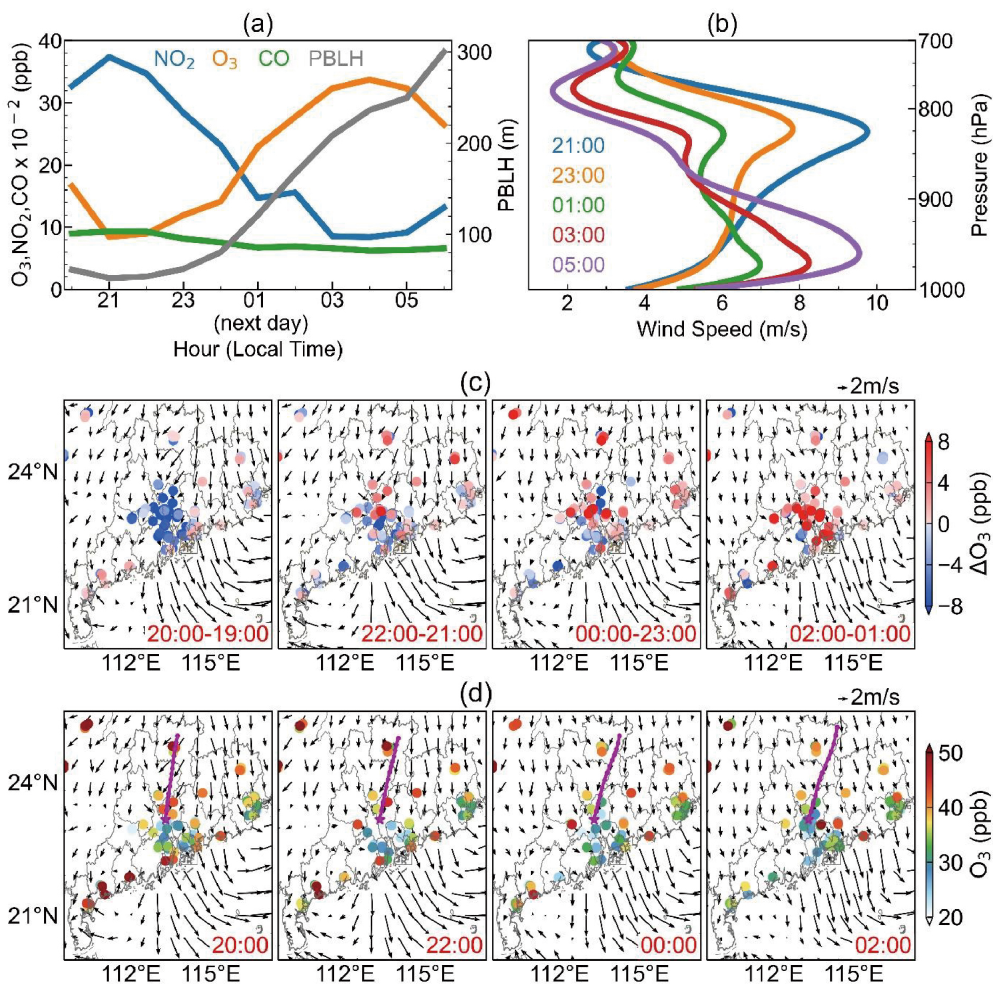
Figure 10. An NOE event in Guangzhou on 21–22 September 2014. Panel (a) shows the hourly variations in nocturnal ozone, NO 2 , and the PBLH. Panel (b) shows the evolution of vertical profiles of wind speed. Panel (c) shows the 10m wind fields and changes in ozone relative to the previous hour. Panel (d) shows the 10m wind fields and hourly ozone concentration. The purple line is the 12h backward trajectories of air masses calculated using the Hybrid Single-Particle Lagrangian Integrated Trajectory (HYSPLIT)